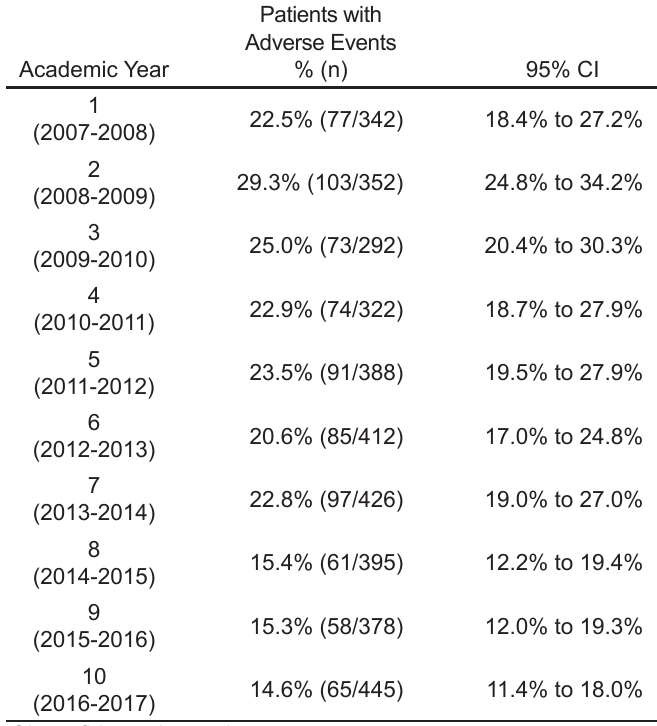
Table 3. Patients with adverse intubation events by year over the 10-year